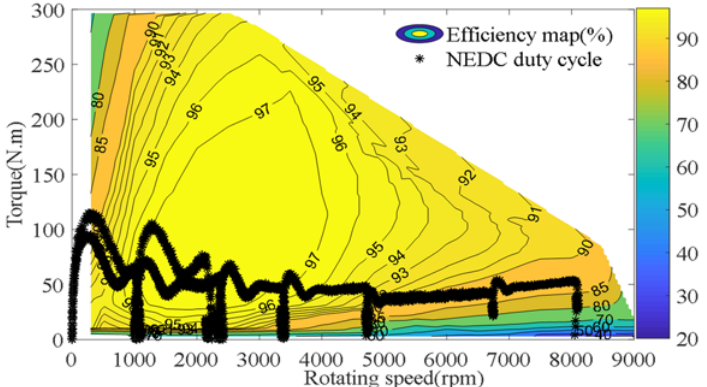
Figure 18. Measured efficiency and operating point of NEDC duty cycle.